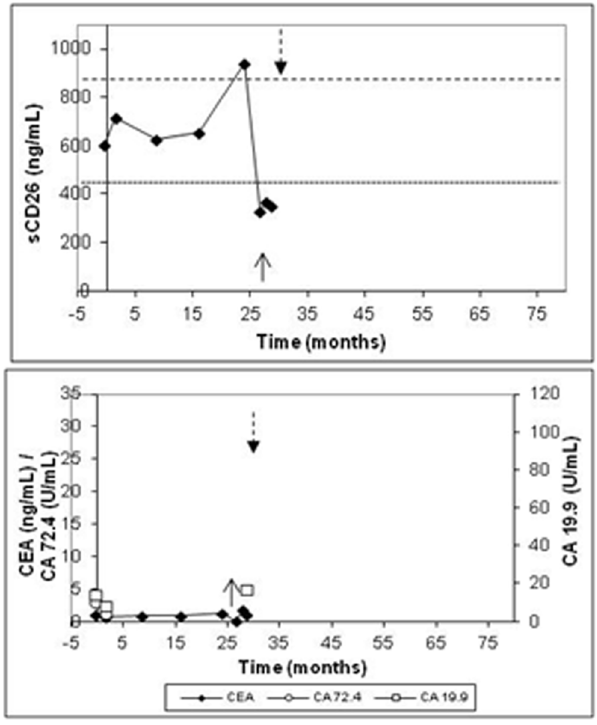
Figure 1. Levels of the sCD26, CEA, CA-19.9 and CA-72.4 in one representative disease-free patient (patient 25). Black arrows indicate beginning and end of chemotherapy cycles.